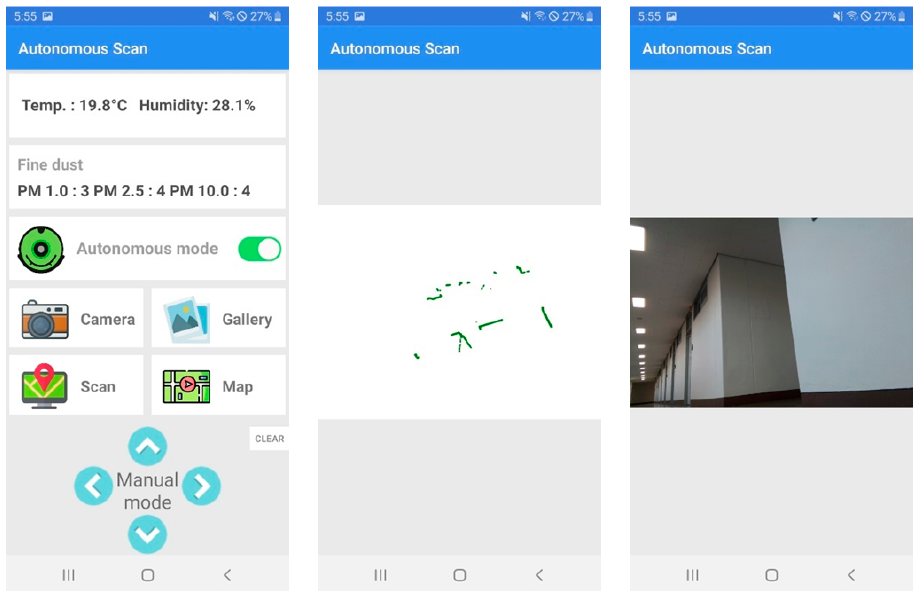
Figure 33. Environmental data result ( left ), captured image ( middle ), and scanned result ( right ) at position (marked 5 in Figure 29) from which third autonomous scanning experiment was performed.